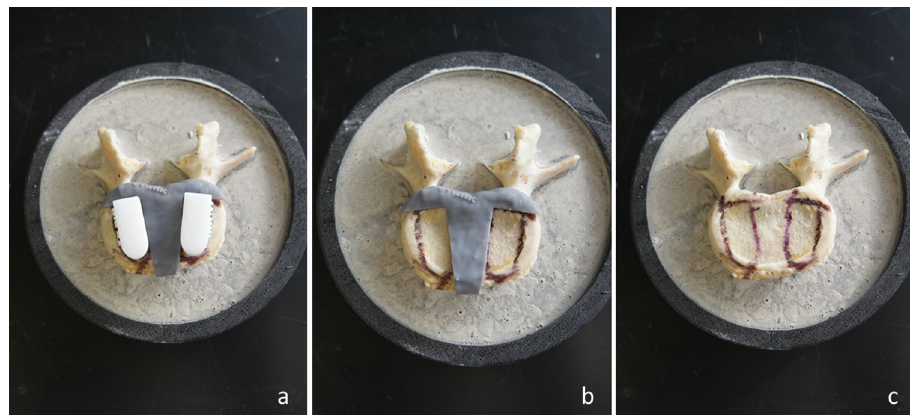
Figure 1. L5 vertebra potted in cement for biomechanical